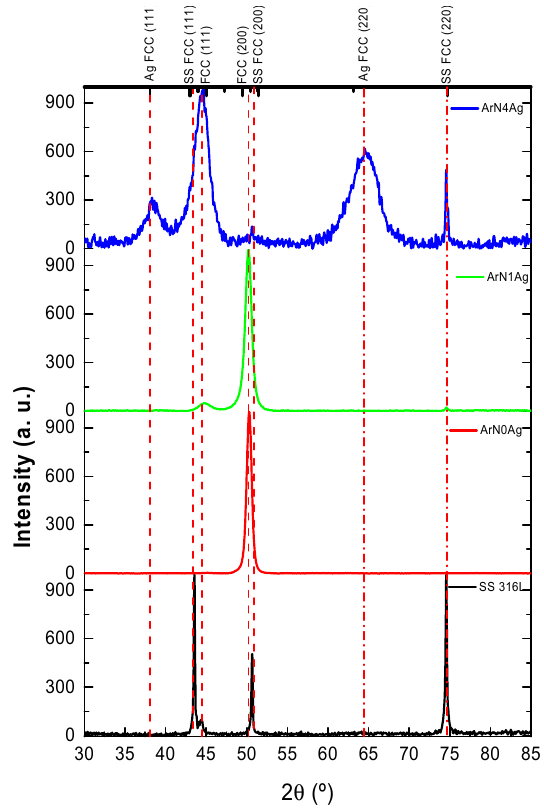
Figure 2. XRD diffraction patterns of stainless steel coatings deposited in Ar + N 2 atmosphere. Table 2. Results of the size of the crystallite ( D ), percentage of deformation ( ε ) and lattice parameter ( a ). Coating Phase Reflection (h k l) D (nm) Ar0Ag